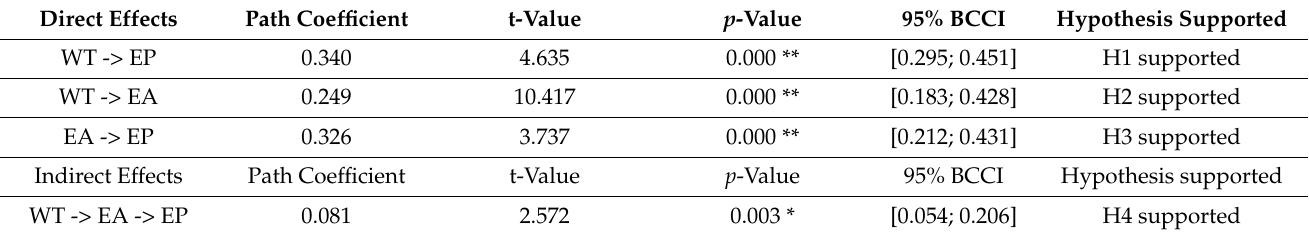
Figure 2. Theoretical model with R-squared, path coefficients ( β ), and significance. Source: compiled by authors. Table 6. Results of the structural model for the mediation model.